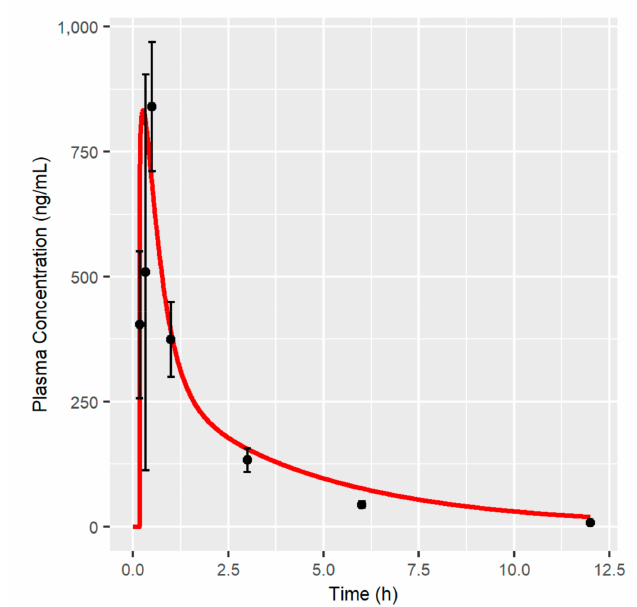
Figure 2. Plasma concentration-time profile after the IP single dose administration of 10 mg / kg of MBQ-167 in mice. Red line represents the typical simulated individual. Black dots represent the mean of all observations at the sample time with the corresponding 95% Confidence Interval (vertical lines).